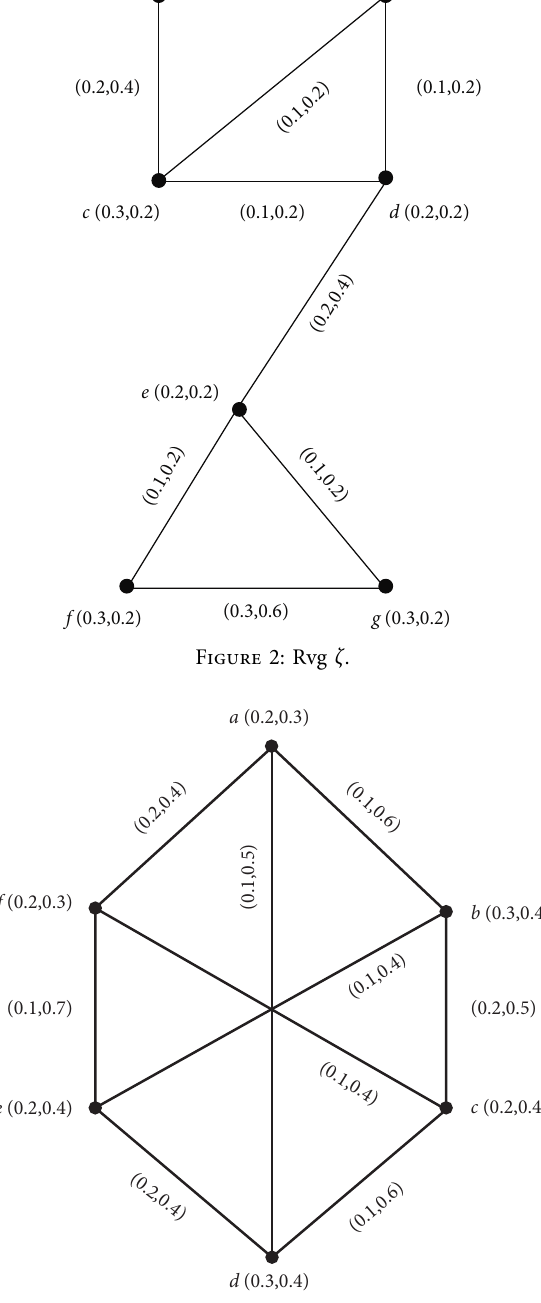
Figure 3: Regular graphs ζ and G ∗ with different adjacency